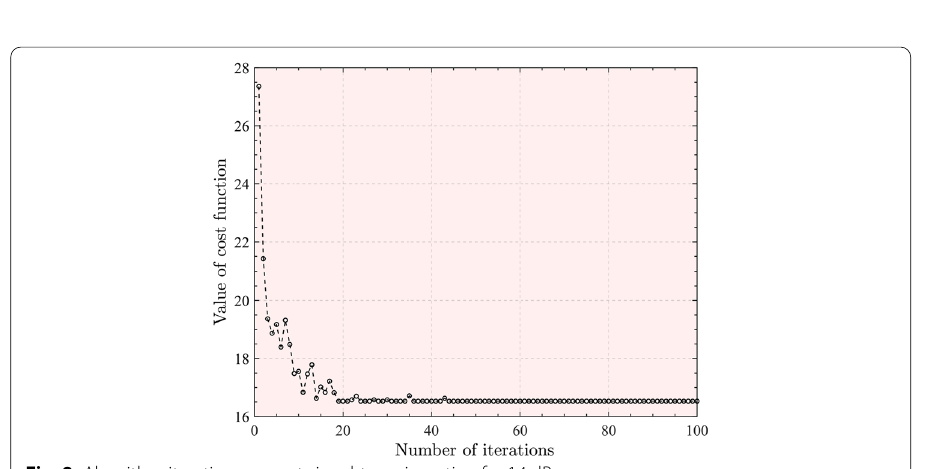
Fig. 8 Algorithm iteration curve at signal-to-noise ratio of